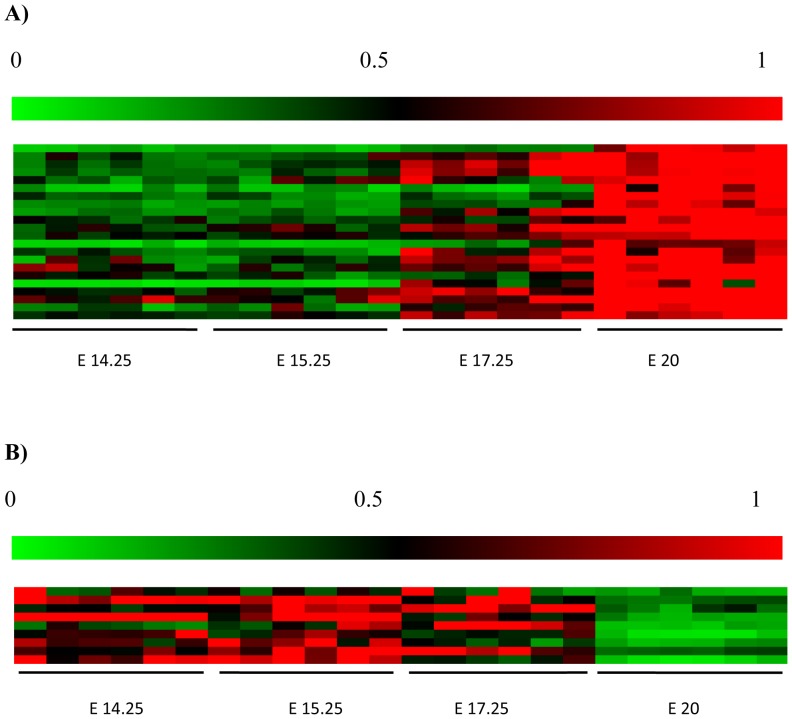
Heat Map of relative expression of Angiogenic genes.Of the 31 differentially expressed genes, 22 were up regulated (A) and 9 were down regulated (B). The heat map diplays data for 6 individual placentae for each gestational age. The genes correspond to the gene list in Table 1, where a change from green, black to red indicates and increase in signal. The colour legend above each map shows relative microarray signal ranges between 0 to 1. Each coloured rectangular box within the heat map represents a separate rat placenta sample. The samples are grouped according to gestational age i.e. E14.25, E15.25, E17.25, E 20.